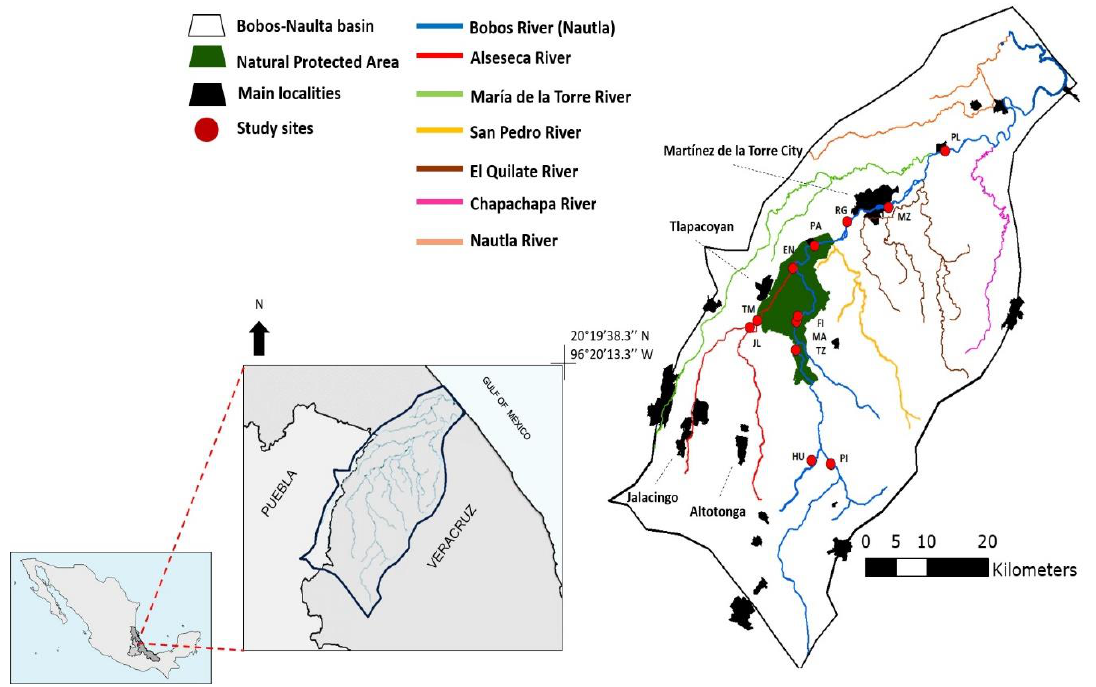
Figure 1. Geographic location of the Bobos river basin and study sites. Red dots mark study sites. PI = Pimiento, HU = Huapala, JL = Jalacingo, TM = Tomata, EN = Encanto, TZ = Tezcapa, MA = Manantial, PI = Puente Filo, PA = Palmillas, RG = Rojo Gómez, MZ = Martínez de la Torre, and PL = Paso Largo.